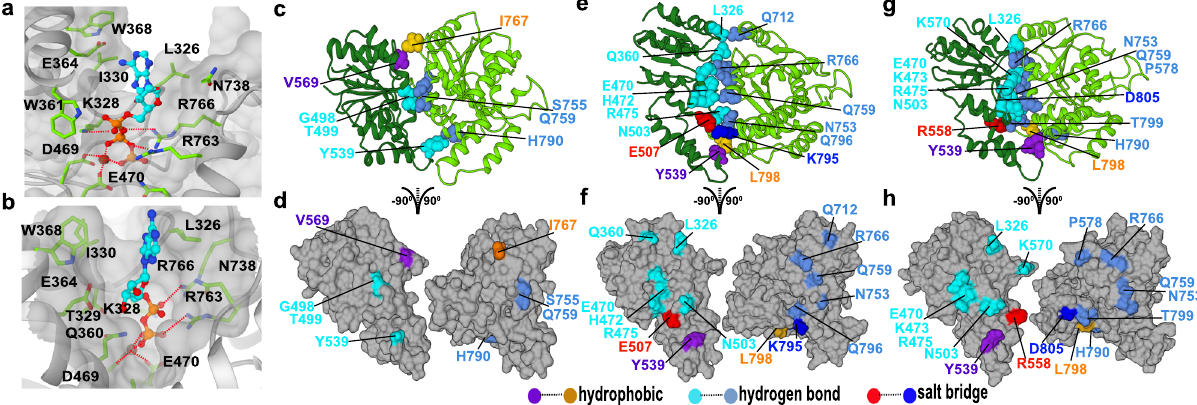
Fig. 2 Structural models elucidate the conformational switching of Rad26 in response to nucleotide binding and its crucial role in transcription bubble remodeling. a View of the Rad26 active site with bound ATP. b View of the Rad26 active site with bound ADP. The binding pocket is shown in gray. Nucleotides are shown in ball-and-stick representation (cyan). Select residues making key contacts with the nucleotide are shown in stick representation (green). Red dash lines denote hydrogen bonds. Mg (dark brown sphere) is coordinated by D469, D470 and ATP/ADP phosphate (red dash lines). ( c , e , g ) Residue contacts at the RecA1 and RecA2 interface in ( c ), apo state; ( e ), ATP state; ( g ), ADP state. ( d , f , h ) Residue contacts mapped onto the RecA1 and RecA2 surface in ( d ). apo state; ( f ), ATP state; ( h ), ADP state. The side chains of contact forming residues are shown with salt – bridge interactions in red and blue, hydrogen bonding interactions between polar residues in cyan and light blue, and hydrophobic interactions in orange and